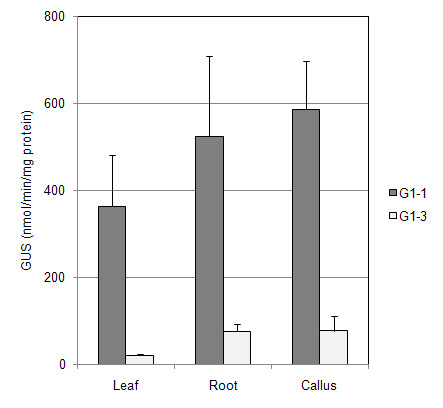
Expression of theuidAgene in transgenicGladiolusorgans and callus. GUS specific activity was measured using three plants for each of the three transformed lines, and the mean and standard error are shown.